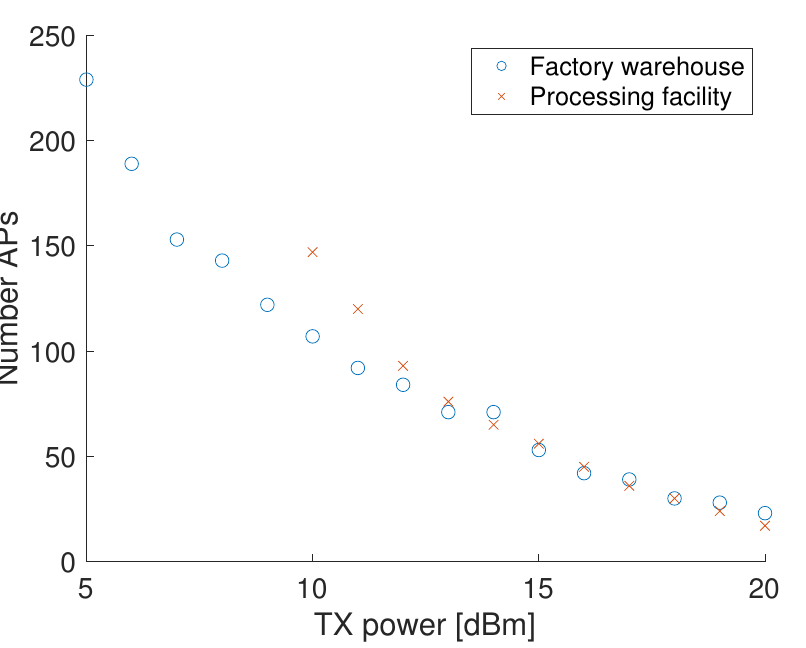
Figure 8. Number of required access points as a function of the maximum transmit power of the access